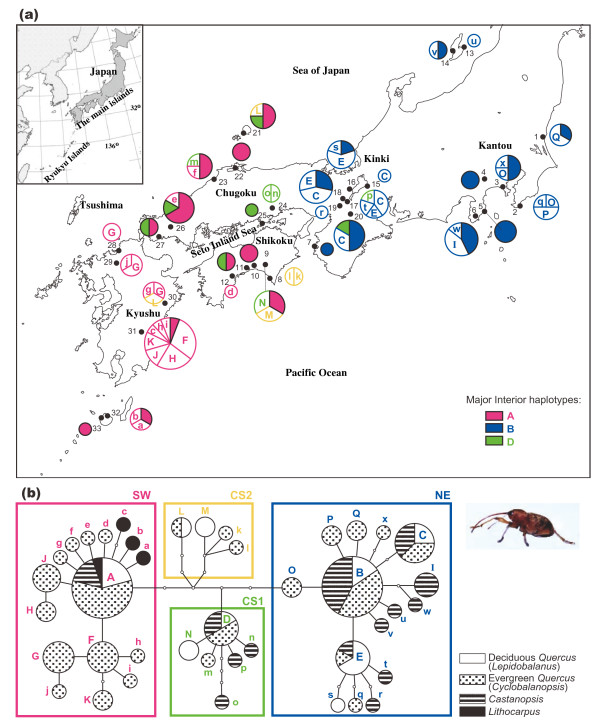
Geographic distribution of mtDNA haplotypes of Curculio sikkimensis. (a) Geographic distribution of 41 mtDNA haplotypes found among 115 individuals of the generalist seed parasitic weevil, C. sikkimensis. Sample size ranged from 1 to 17 individuals per population. Circle sizes are proportional to haplotype frequencies. See Table 1 for the exact locations of populations and host plant species. (b) Relatedness among haplotypes detected in 921 bp of mtDNA (COI) of C. sikkimensis, represented in a statistical parsimony haplotype network. Each haplotype indicates the proportion of a host plant genus. Circle sizes are proportional to haplotype frequencies, and open dots indicate missing intermediate haplotypes.